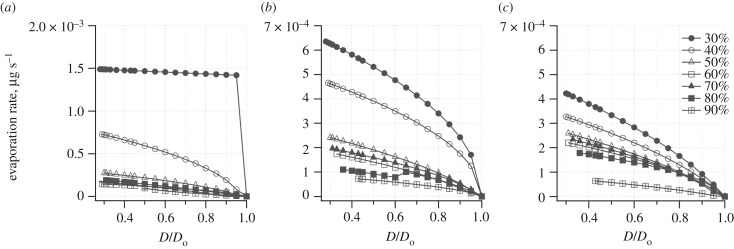
Evaporation rate of droplets at different RHs as a function of dimensionless droplet diameter (D/Do). (a), (b) and (c) are plots obtained from droplets aerosolized from 3C, 4C and HS solutions, respectively. At each RH, the minimum D/Do value corresponds to the equilibrium diameter (Deq) calculated according to the Kohler equation or to the diameter of the solids in the case of RH lower than the efflorescence RH (ERH) of NaCl (approx. 44%). The legend for each RH is indicated in c. RH was held constant at the value indicated for that curve. Evaporation rates were obtained for droplets in contact with a superhydrophobic surface and without ventilation. Hence, results can only be interpreted qualitatively in applying them to airborne droplets under real environmental conditions.